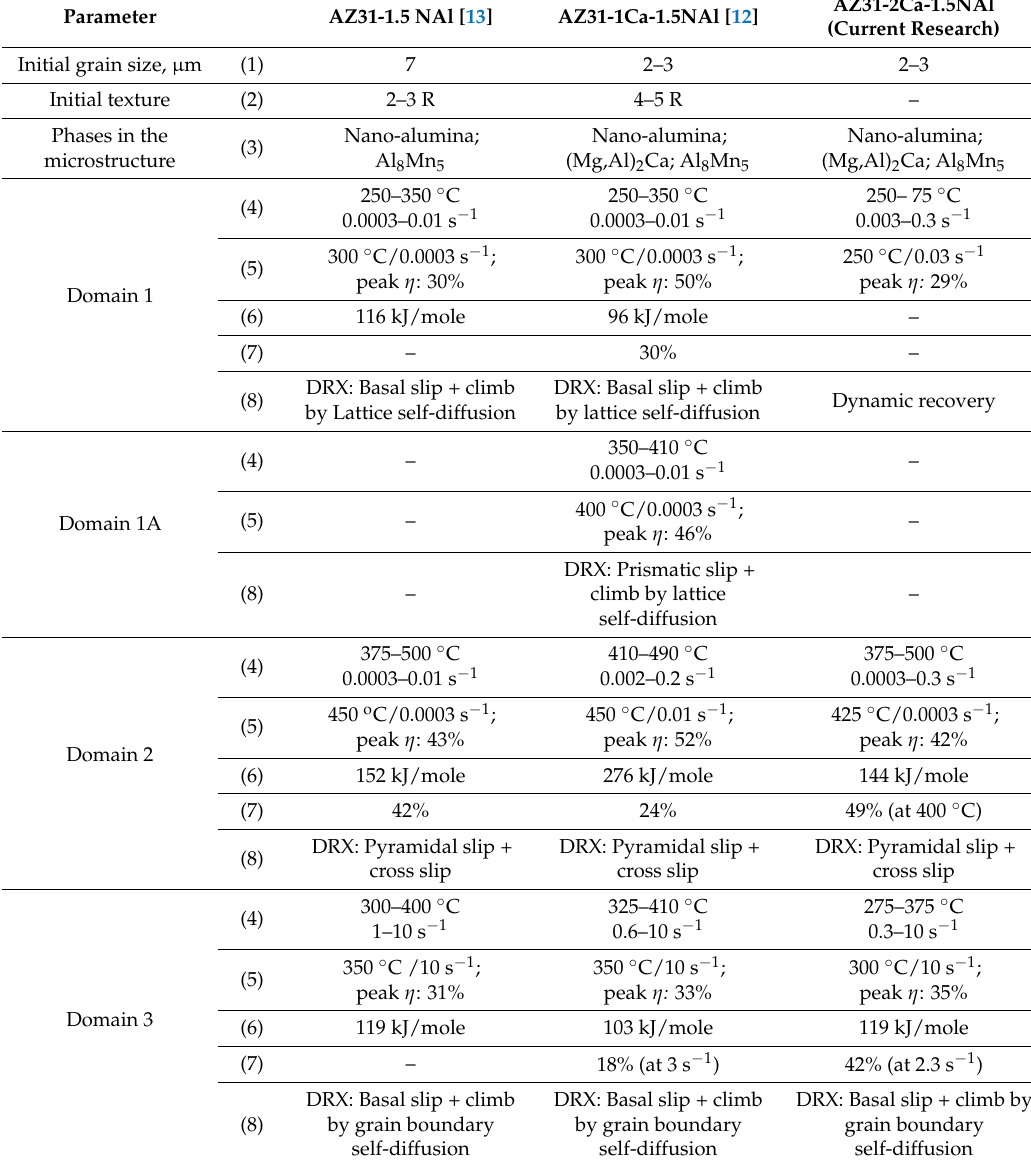
Table 1. Details of microstructural parameters (1–3), (4) temperature–strain rate ranges for domains, (5) peak efficiency ( η ) conditions, (6) apparent activation energy ( Q app ) and (7) tensile elongation, and (8) proposed mechanisms in the various domains of processing maps for DMD-processed AZ31-1.5